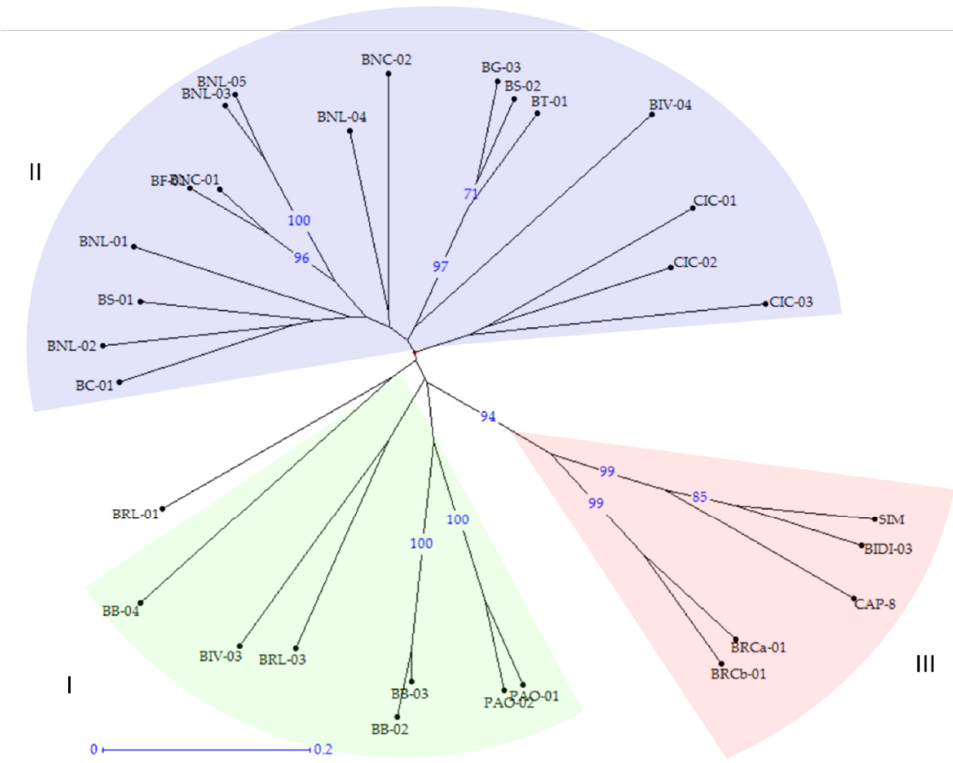
Figure 4. Dendrogram of 30 tetraploid wheats genotypes. Simeto (SIM), Bidì (BIDI-03) and Capeiti (CAP-8) durum wheat varieties were used as outgroup. Dendrogram generated using the neighbor joining method (NJ) and Nei’s distance. Groups are indicated by different colors corresponding to STRUCTURE clustering colors and by Roman numbers.